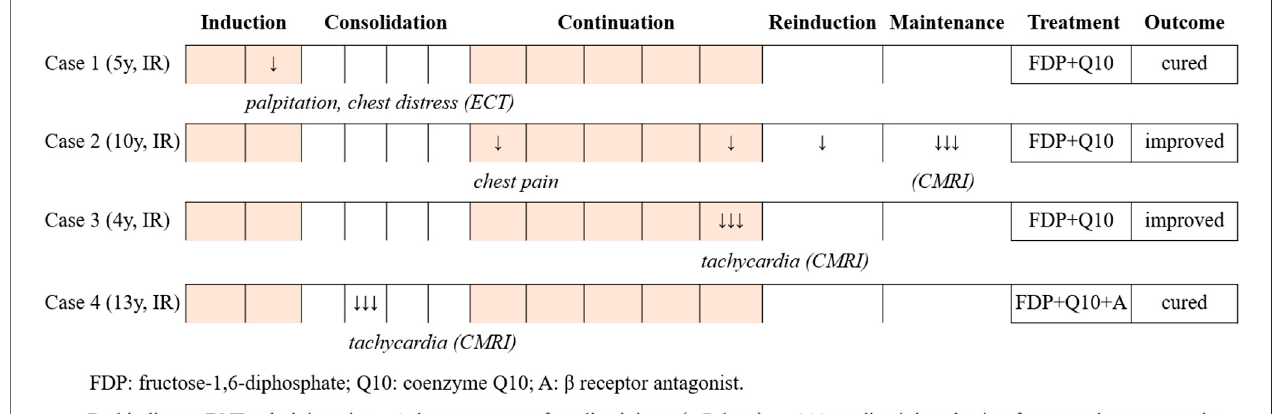
FIGURE 3 | Clinical features and outcomes of patients with cardiac disorders after DNR